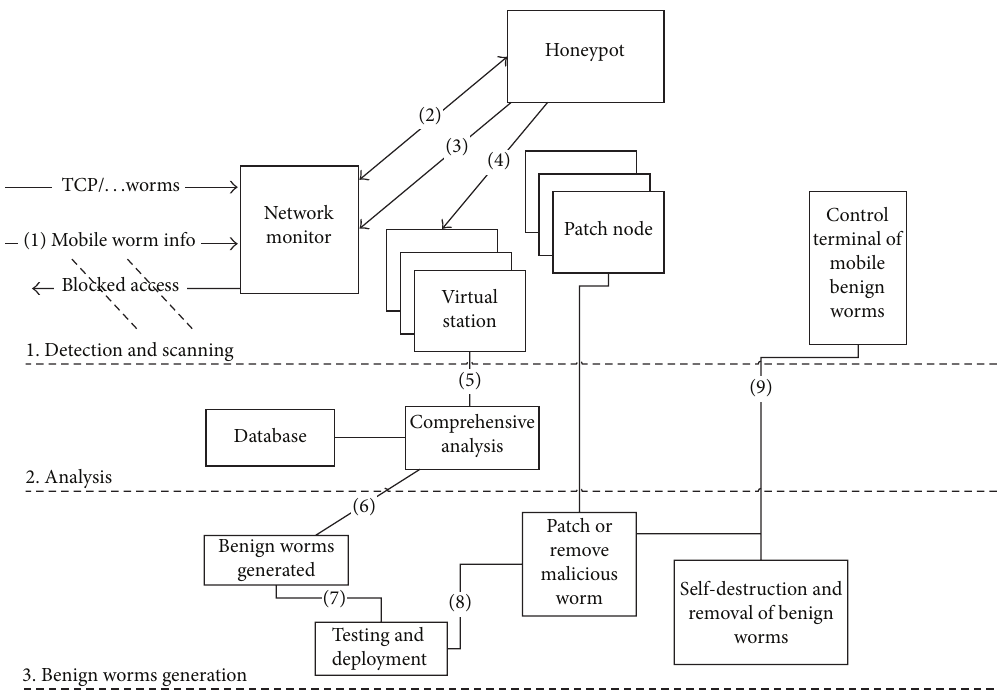
Figure 5: Benign worm mechanism based on